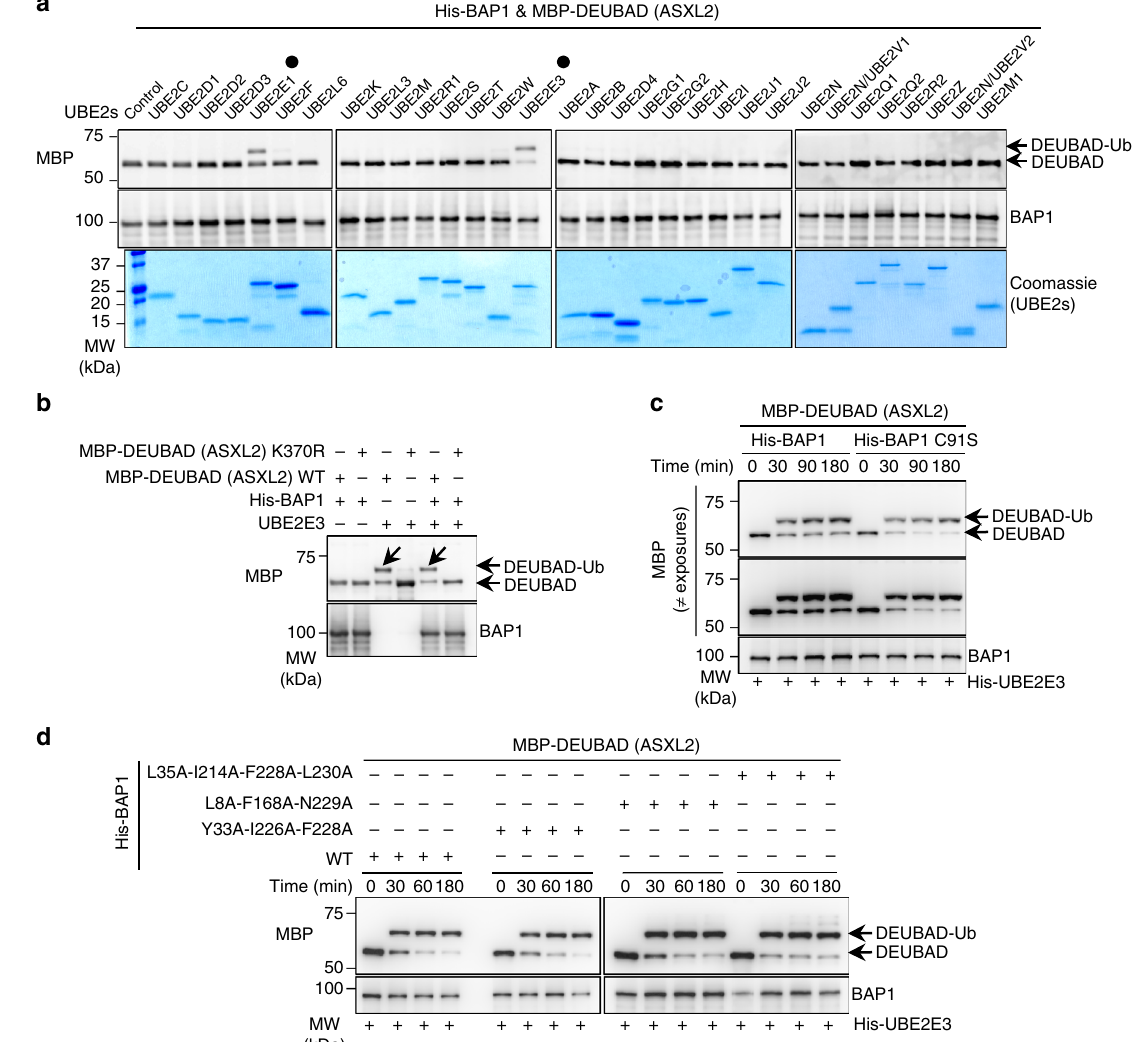
Fig. 5 DEUBAD monoubiquitination is directly catalyzed by UBE2E family. a UBE2E1 and UBE2E3 directly catalyze monoubiquitination of DEUBAD (ASXL2). Bacterial puri fi ed His-BAP1/MBP-DEUBAD (ASXL2) complex was incubated with the indicated recombinant UBE2s conjugating enzymes for in vitro ubiquitination assays. The reactions were analyzed by western blot as indicated. The black dots indicate UBE2E1 and UBE2E3. n = 1 biological sample. b UBE2E3 in vitro monoubiquitinates K370 of DEUBAD (ASXL2) alone or DEUBAD (ASXL2) in complex with BAP1. Bacteria puri fi ed MBP-DEUBAD (ASXL2), MBP-DEUBAD (ASXL2) K370R, His-BAP1/MBP-DEUBAD (ASXL2) and His-BAP1/MBP-DEUBAD (ASXL2) K370R complexes were used